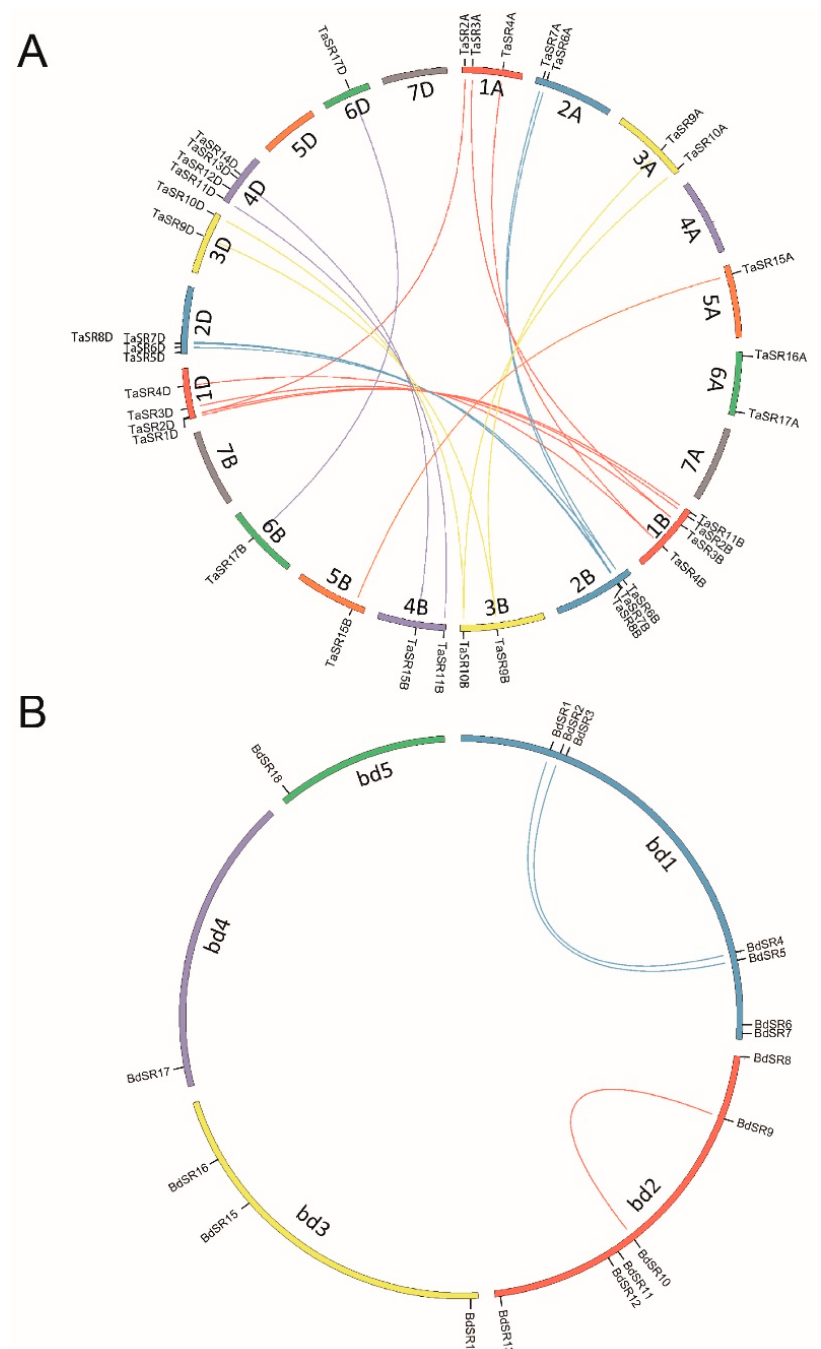
Figure 1. Schematic representations for the inter-chromosomal relationships of wheat and B. distachyon serine/arginine-rich (SR) protein genes. ( A ) Genomic locations and segment duplications of TaSR protein genes; ( B ) genomic locations and segment duplications of BdSR protein genes.